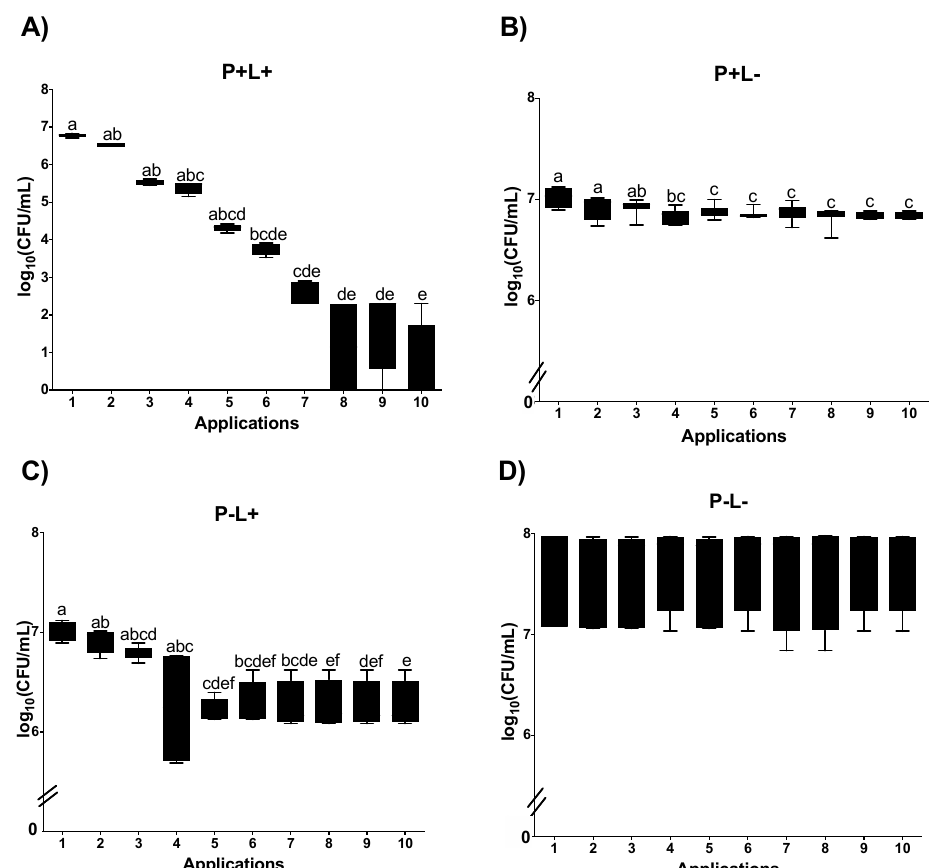
Figure 6. Log 10 values (CFU/mL) of C. albicans biofilms submitted to ( A ) aPDT (P+L+), ( B ) PDZ (P+L − ), ( C ) light (P − L+), and experiment control ( D ) (P − L − ). Upper limit of the box: third quartile; lower limit of the box: first quartile; error bars: minimum and maximum values. Different letters (a; b; c; d; e; f) denote a statistical difference between columns (applications) according to Dunn’s post-test ( p < 0.05) ( n = 12).